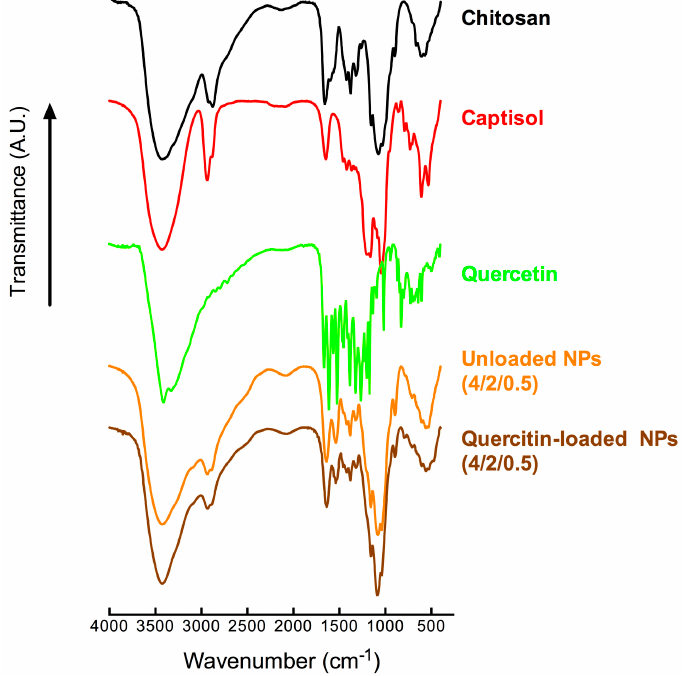
Figure 8. FTIR transmission spectra of free chitosan, Captisol ® , quercetin, unloaded and quercetin- loaded CS/SBE β CD/TPP 4/2/0.5 nanoparticles.